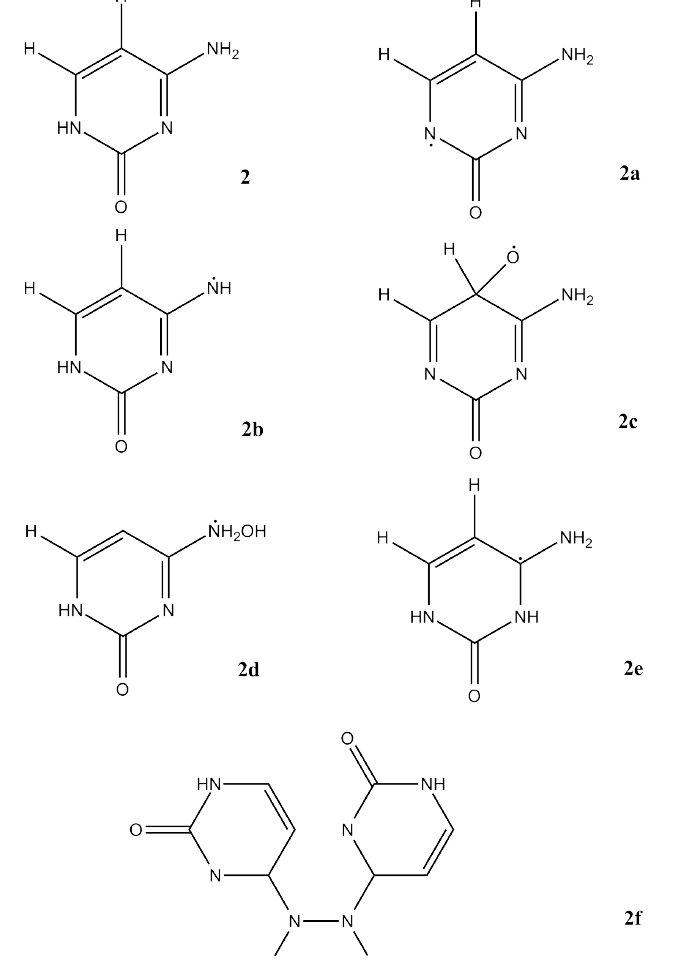
Figure 5. Reaction products of the electrolysis of cytosine 2 . 2e was the only reaction product observed in the cathodic space.